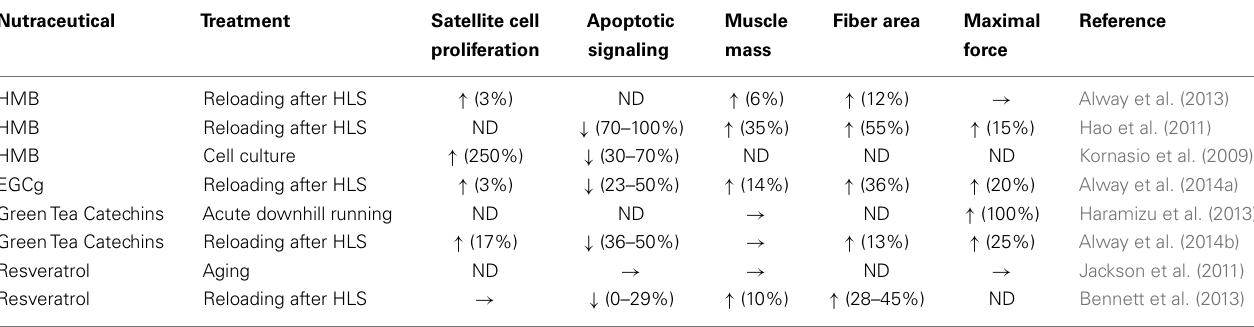
Table 2 | Summary of nutraceutical effect on satellite cell function, apoptosis and muscle function in growing/regenerating aged muscle .